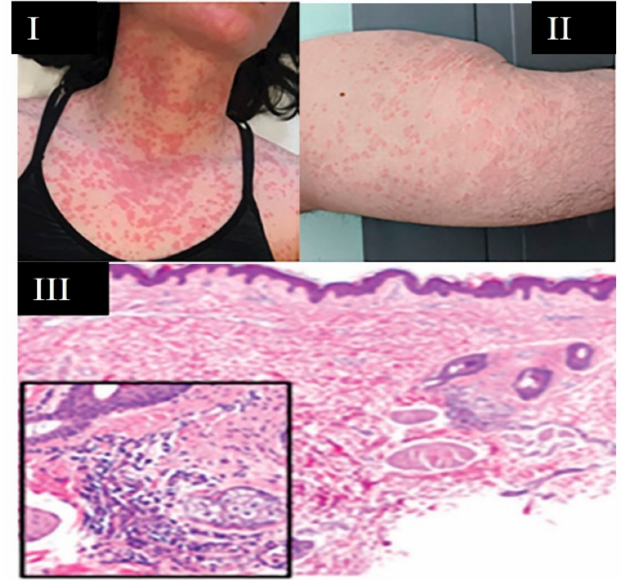
Figure 7. Urticarial Rash. ( I ) Urticarial rash, similar to hives, appearing on patient’s neck and chest; ( II ) urticarial lesions dispersed along buttocks and proximal lower extremity (thigh); ( III ) urticarial pattern with mild edema, perivascular inflammation, and dilated vessels in the upper dermis. Inset: vessels filled with neutrophils and mixed perivascular inflammation. Singh H. et al. (2021)